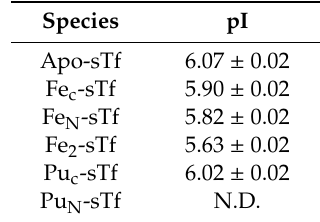
Table 2. The isoelectric points (pI) of apo-sTf and di ff erent M-sTf complexes. The pI values were taken from Ref. [59]. (N.D. = Not determined).